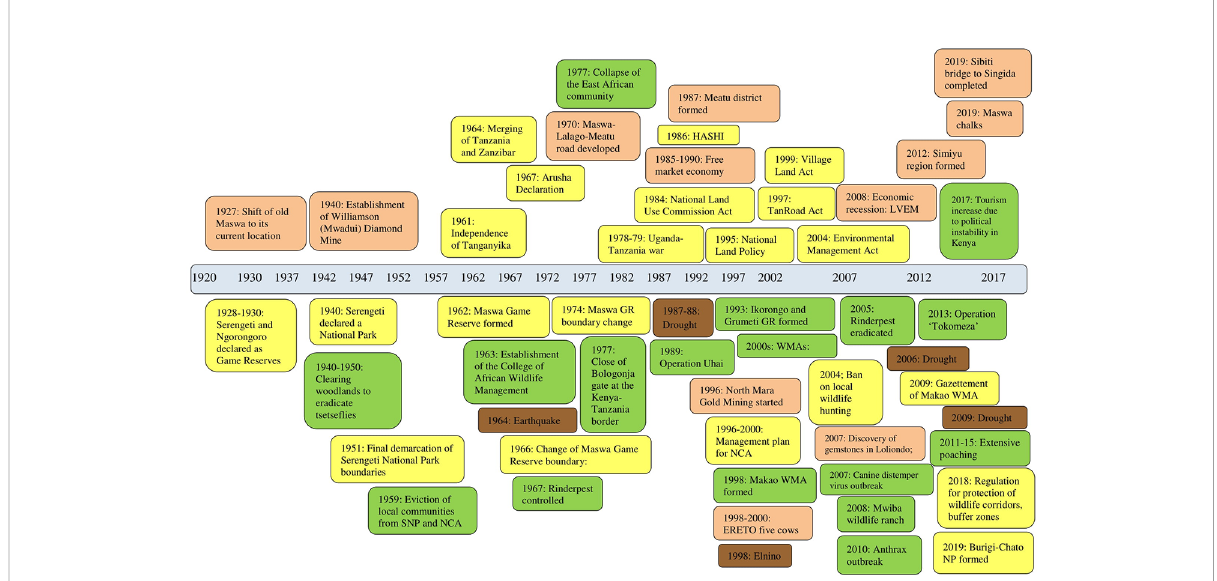
FIGURE 4 Timeline of events that in fl uenced land use and land cover patterns in the wider Serengeti ecosystem. Events are categorized by color: administration, infrastructure development, and socio-economic factors (orange); legislation (yellow); use and management of natural resources such as wildlife and forests (green); and climate variability and natural catastrophe